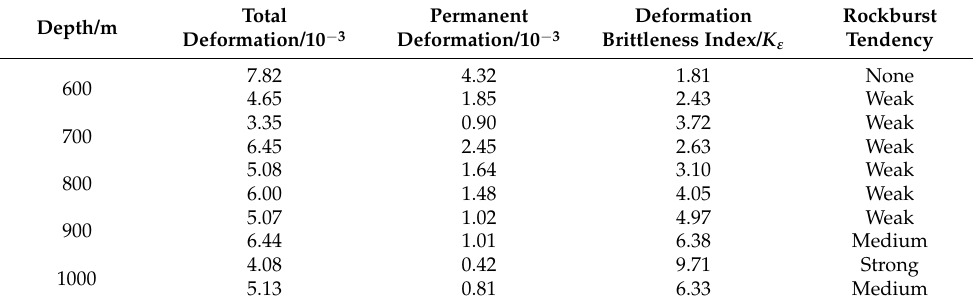
Table 3. Rockburst tendency based on deformation brittleness index